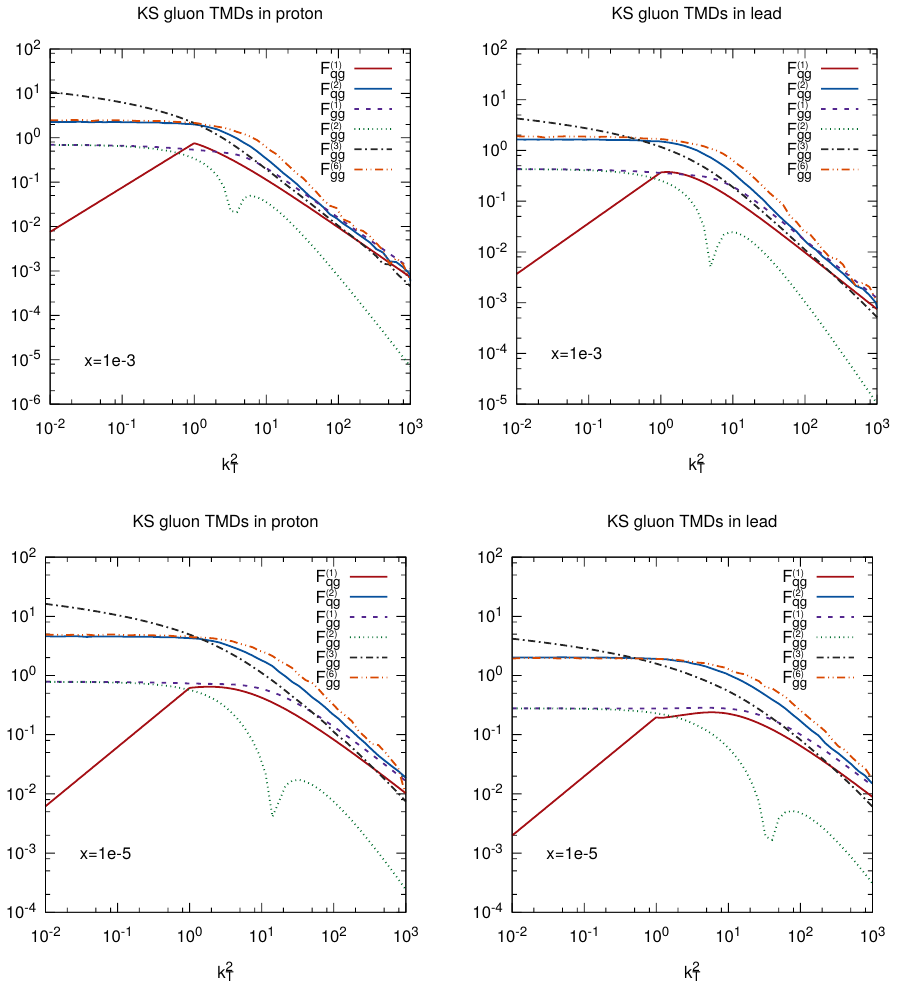
Figure 1 . The KS TMD gluon distributions for p and Pb at x = 0 : 001 (top) and x = 0 : 00001